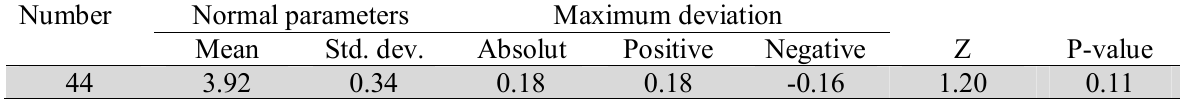
The summary of Kolmogorev-smirnov test Number Normal